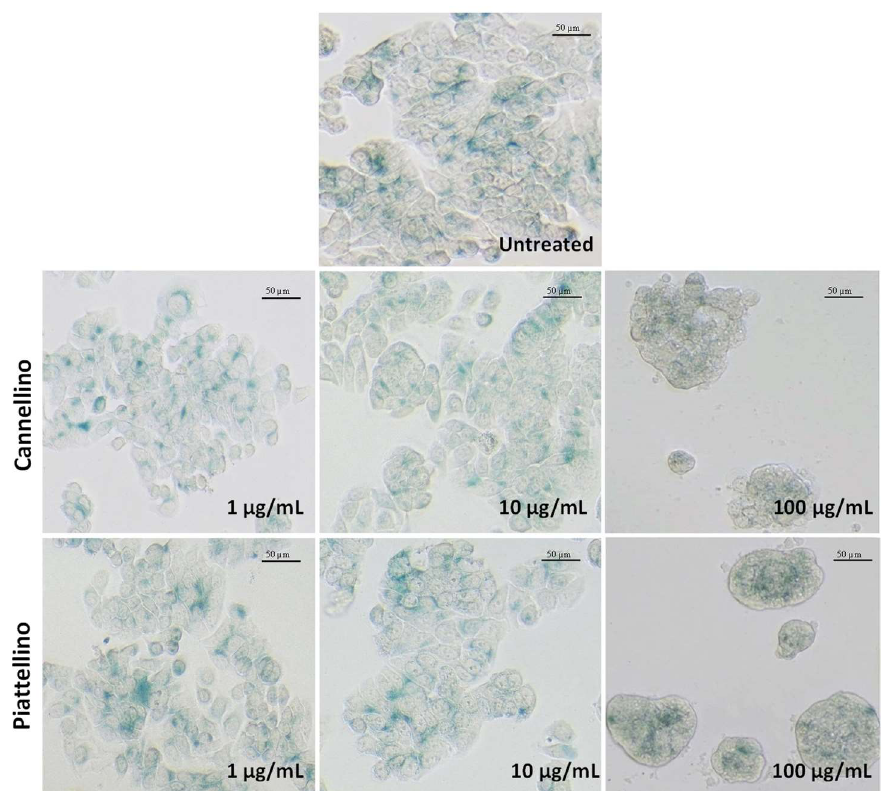
Figure 8. Effects of Cannellino and Piattellino BF on cellular senescence. HT29 cells were treated with Cannellino and Piattellino BF (1, 10, and 100 μg/mL) for 24 h. The figure reports images of cells after staining for β -galactosidase activity, with the blue color representing senescent cells. Data are representative of three different experiments.